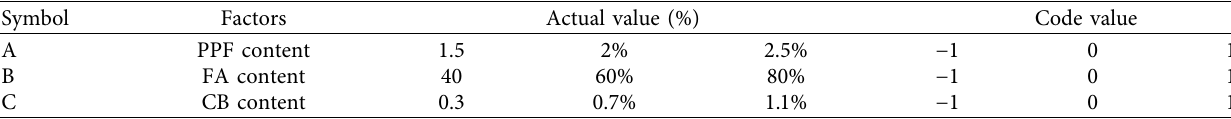
Figure 2: Loading diagram of test methods for flexural strength (a) and splitting strength (b). Table 3: The level of experimental factors.